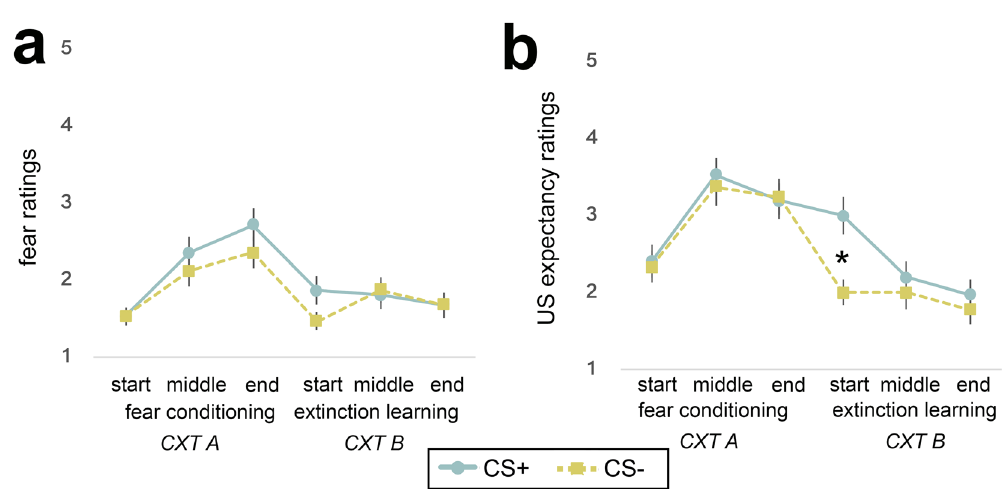
Figure 2. Fear and US expectancy ratings during fear conditioning and extinction learning in children. Significant increase in fear ( a ) and US expectancy ratings ( b ) for the CS + but not the CS − over the course of fear conditioning, suggesting intact conditioning. At the start of extinction, US expectancy ratings were significantly higher for the CS + relative to the CS − , further suggesting differential conditioning. During extinction learning, there was a decline in fear and US expectancy ratings for the CS + and the CS − , suggesting intact extinction. Fear (“How scary is this?”, 1 = not scary, 5 = very scary), and US expectancy (“Do you think that you will hear a loud sound with this?”, 1 = definitely not, 5 = definitely yes) ratings are submitted at the beginning (‘start’), after the first half (‘middle’), and at the end (‘end’) of each session. CS + and CS − refer